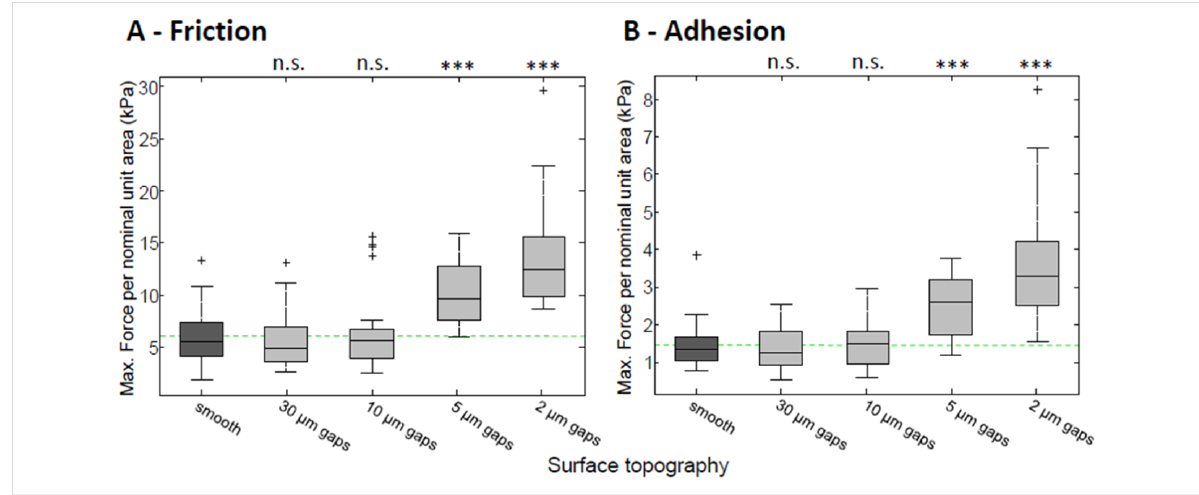
Figure 3: Force measurements of single toe pads on PDMS rough surfaces. The pads force per (nominal) unit area is shown for friction (A) and for adhesion (B), on rough surfaces (varying in the size of the gap between the asperities). They are compared to the forces produced on a smooth sur- face (dark grey). The green dashed lines show mean values on the smooth surface to aid comparisons. Statistical tests are denoted above each box (due to the Bonferroni correction: 95% confidence interval p = 0.0125 (*), 99% p = 0.0025 (**), 99.9% p = 0.00025 (***), and n.s. = not significant).